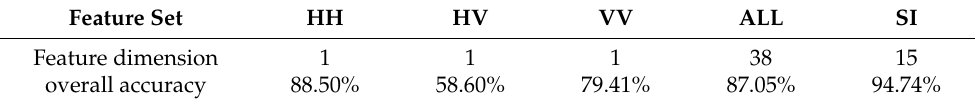
Table 4. Accuracy results of feature classification in Yancheng coastal wetland.